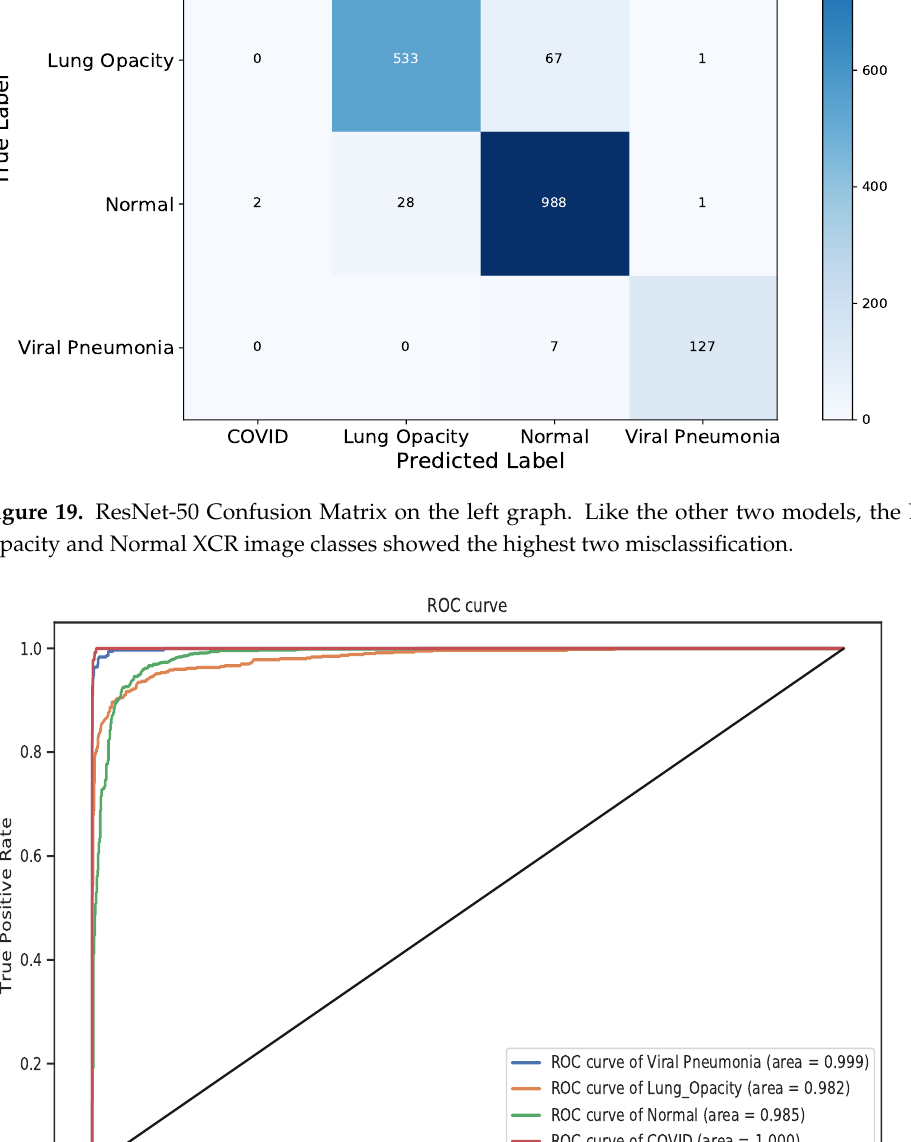
ROC curve of Viral Pneumonia (area = 0.999) ROC curve of Lung_Opacity (area = 0.982) ROC curve of Normal (area = 0.985) ROC curve of COVID (area = 1.000) random guessing